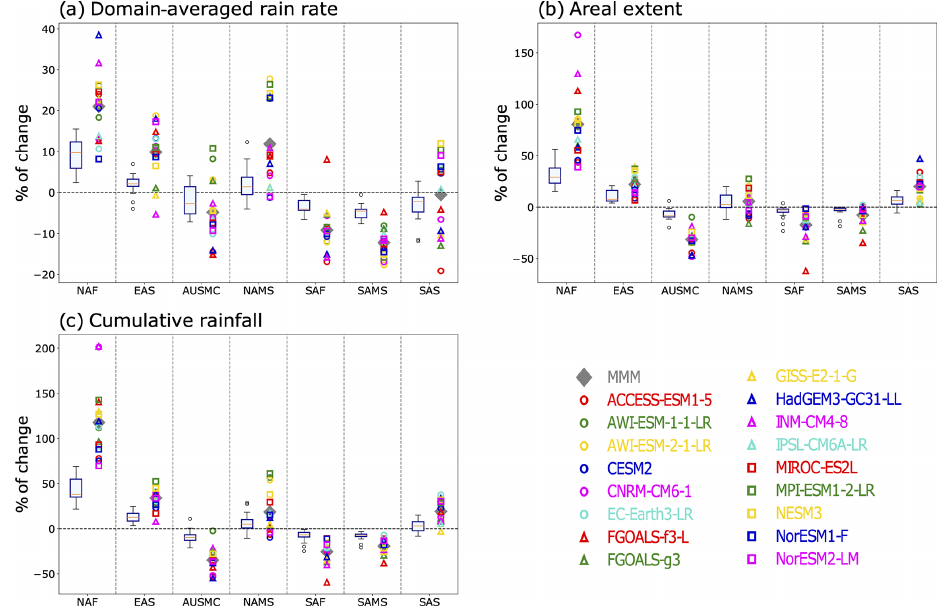
Figure 16. Relative changes in MMM and individual lig127k monsoons. Three different monsoon diagnostics as computed for each of seven different regional domains for the individual CMIP6 lig127k simulations. The comparable results from the midHolocene simulations are shown with boxes and whiskers (for details, see Brierley et al., 2020). (a) The percentage changes in area-averaged precipitation rate during the monsoon season; (b) the percentage change in the areal extent of the regional monsoon domain; (c) the percentage change in the total amount of water precipitated in each monsoon season (computed as the precipitation rate multiplied by the areal extent). The abbreviations used to identify each regional domain are as follows: North America Monsoon System (NAMS), North Africa (NAF), southern Asia (SAS), and East Asia (EAS) in the Northern Hemisphere and South America Monsoon System (SAMS), southern Africa (SAF), and Australian–Maritime Continent (AUSMC) in the Southern Hemisphere. Note that 14 models completed both the midHolocene and lig127k experiments. Three models (ACCESS-ESM1-5, AWI-ESM-2-1-LR, CNRM-CM6-1) completed only the lig127k experiment, while three models (MRI-ESM2-0, UofT-CCSM-4, BCC-CSM1-2) completed only the mid-Holocene